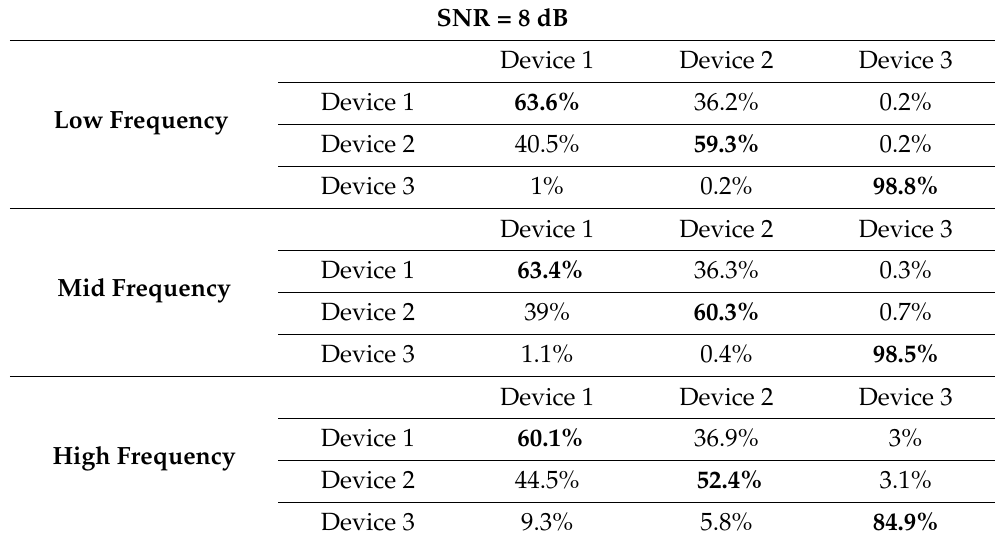
Figure 14. Classification performance of the Fourier features in harmonic space for varying SNR values.